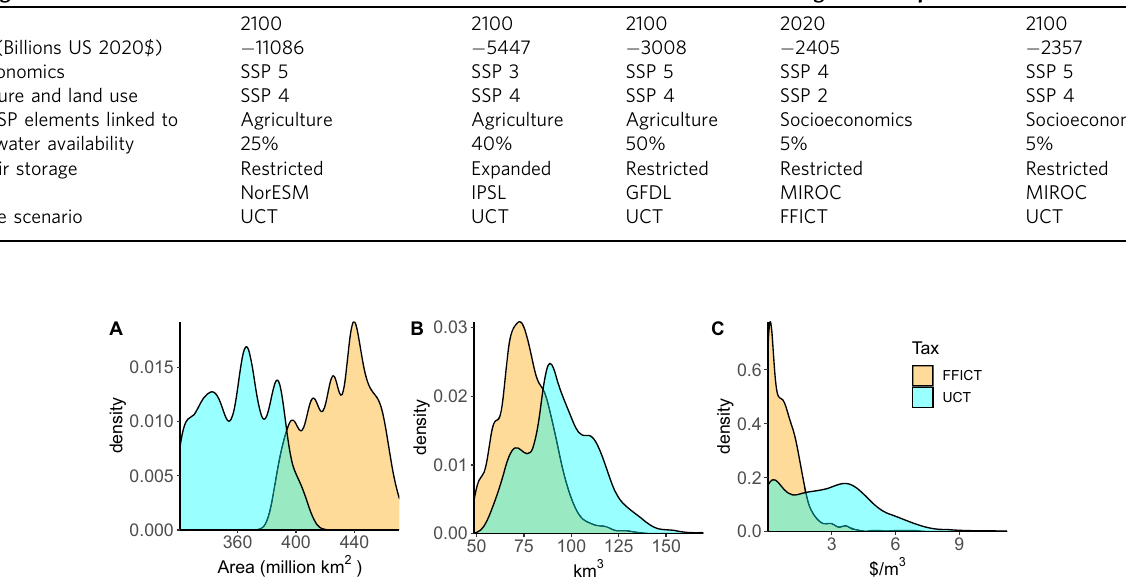
Table 2 The top fi ve basins with the most highly negative economic impact in a time period and scenario. Hydrologic basin